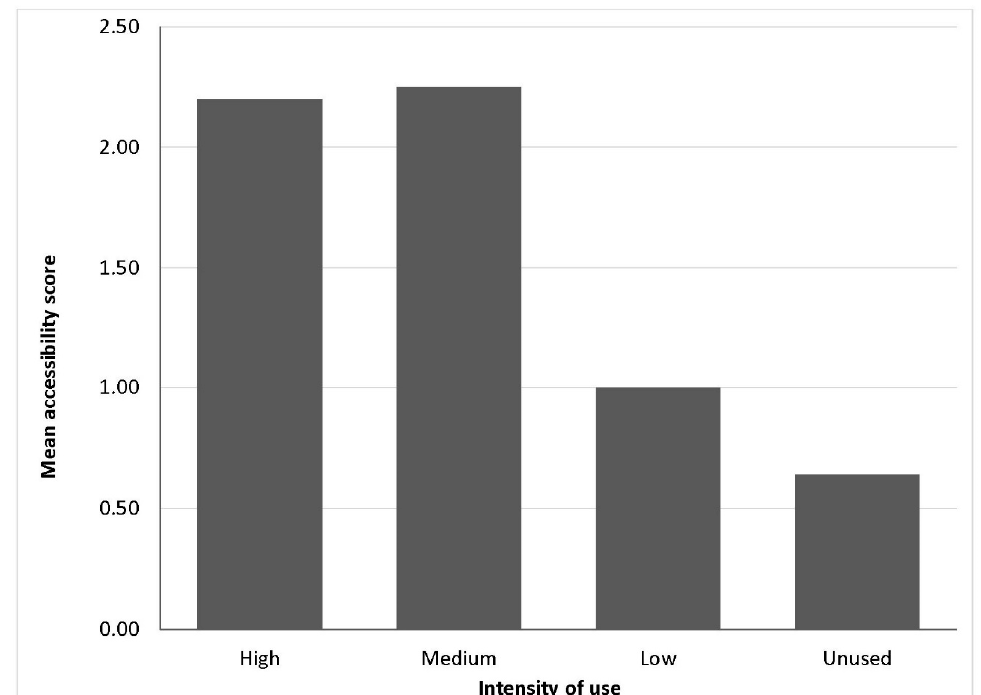
Figure 2. Mean accessibility scores for eleven abandoned houses with high, medium, and low intensity of use by homeless persons and eleven abandoned houses not used by homeless persons. A higher score (maximum = 3) indicates greater ease of access.